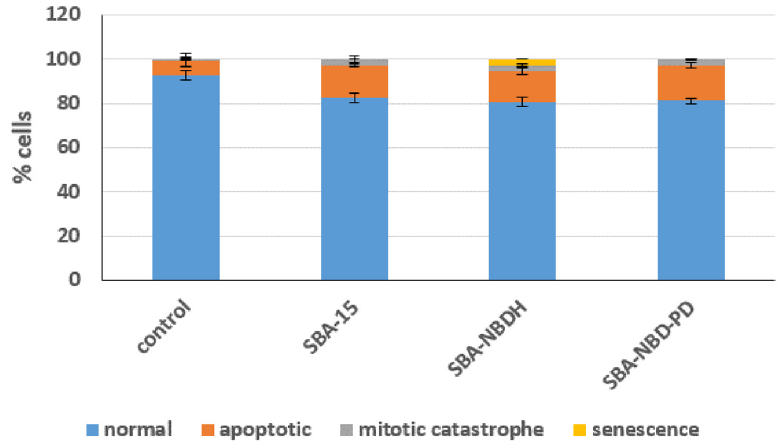
Figure 14. Cells death induced by 125 g/mL nanoparticles, SBA-15, SBA-NBDH, SBA-NBD-PD, in B16 cells. Cells were treated for 16 h and after 5 days subjected to morphological evaluation and classification as apoptotic, multinuclear, or senescent. Data are presented as mean ± SEM.